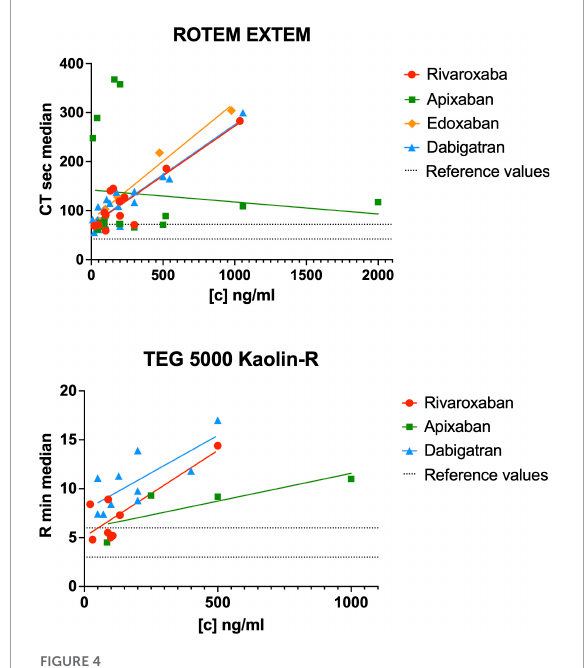
FIGURE4 Reported clotting time (CT) and reaction time (R) in relation to the DOAC plasma concentration of the included studies for the ROTEM EXTEM and TEG 5000 kaolin assays. [c] DOAC plasma concentration in ng/ml. The dashed lines represent the lower and upper reference values for ROTEM EXTEM CT [42, 72 s (88)] and TEG 5000 R [3, 6 min